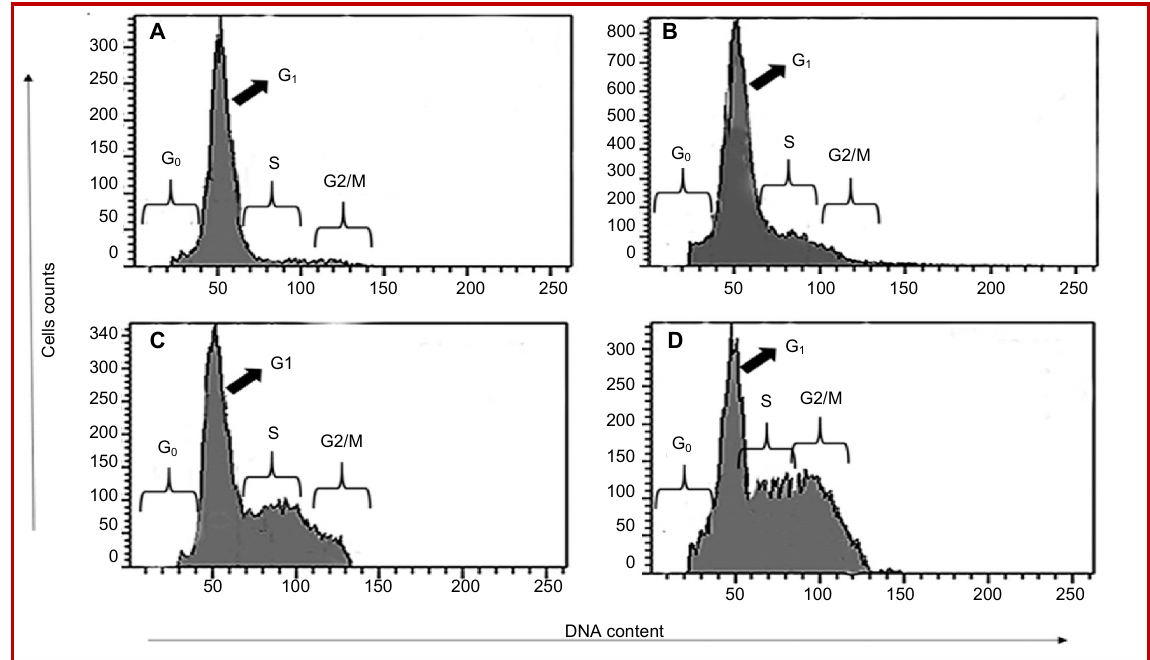
Figure 4: Effect of theaflavin-3-gallate on cell cycle phase distribution in A-549 non-small cell lung cancer cells. The cells were treated with different doses of the compound for 48 hours. The cell cycle distribution was determined by a flow cytometric anal- ysis of the DNA content after staining with propidium iodide. A, shows control while as B, C and D represent cells treated with 20, 80 and 160 µM dose of theaflavin-3-gallate respectively